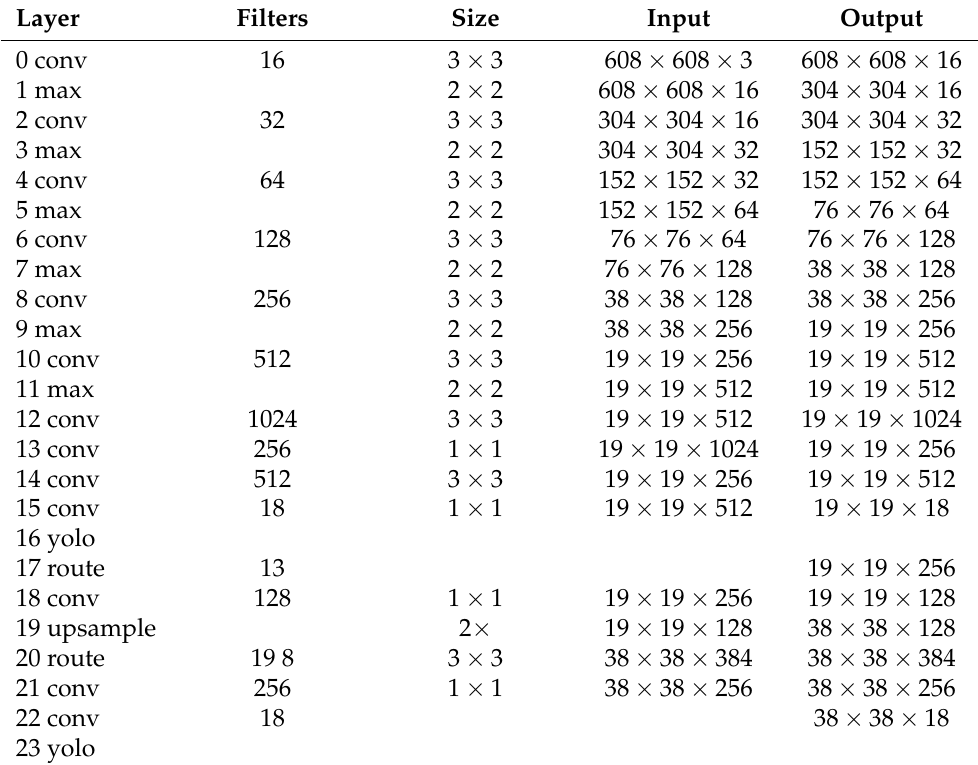
Table A4. Tiny YOLOv3 Architecture. Layer 16: [yolo] params: iou loss: mse, iou norm : 0.75, obj norm